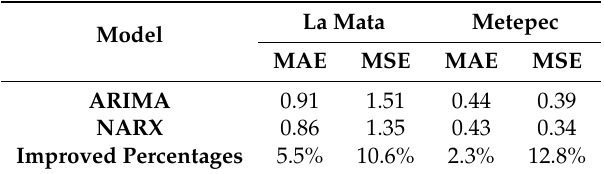
Figure 14. Qualitative comparison of wind speed forecasting for Metepec. Table 5. Statistical errors generated by the ARIMA and NARX